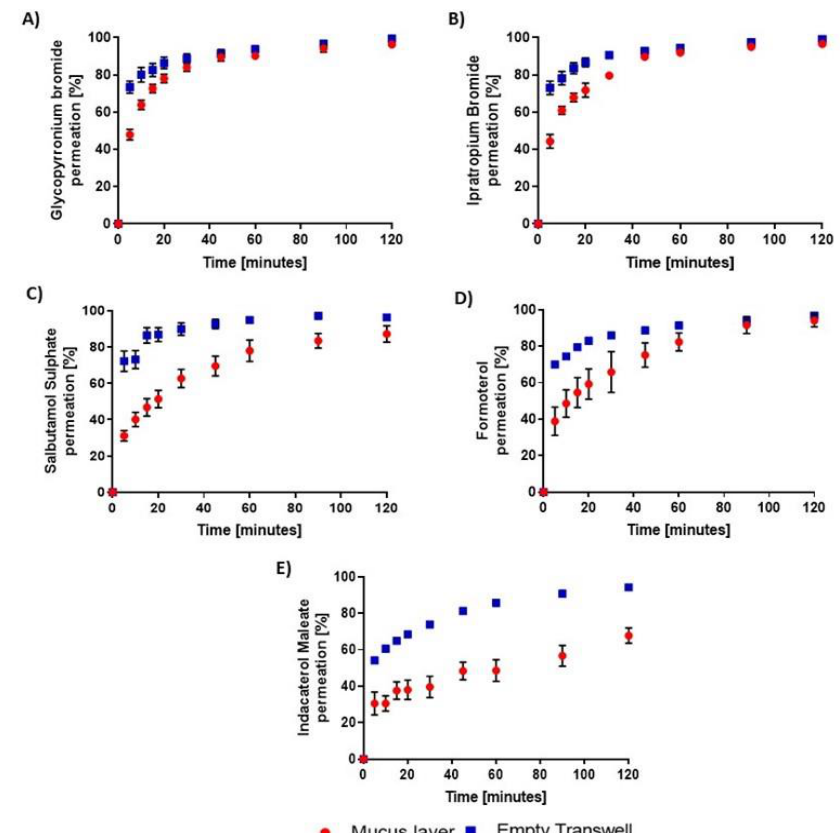
Figure 5. Permeation profiles of inhaled bronchodilators after they were sprayed at a distance of 20 cm onto mucus layers mounted onto 0.4 µ m pore size polyester Transwell ® inserts or corresponding empty inserts arranged to cover a 50 cm 2 surface area. A : glycopyrronium bromide; B : ipratropium bromide; C : salbutamol sulphate; D : formoterol; E : indacaterol maleate. Data are expressed as cumulative percentage of the deposited dose recovered in the basolateral compartment as a function of time. They are presented as mean ± SEM (N = 4, n =